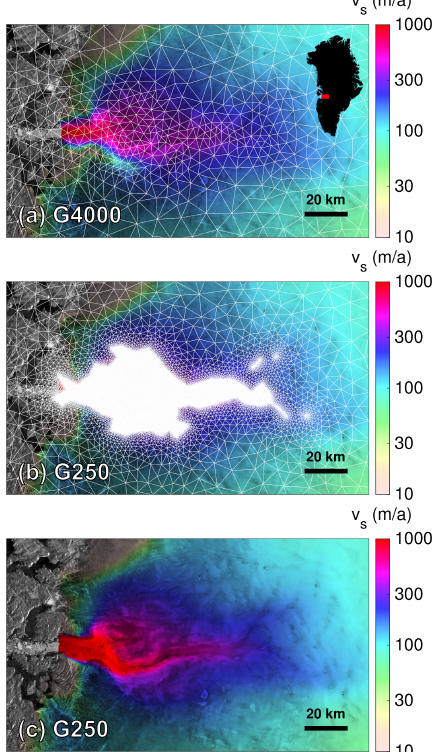
Figure A1. Horizontal mesh and simulated surface velocities, v s , of the Jakobshavn Isbræ: (a) G4000, (b) G250 and (c) the same as panel (b) but without mesh. The location is shown by the red inset in panel (a) . The background image is a RADARSAT